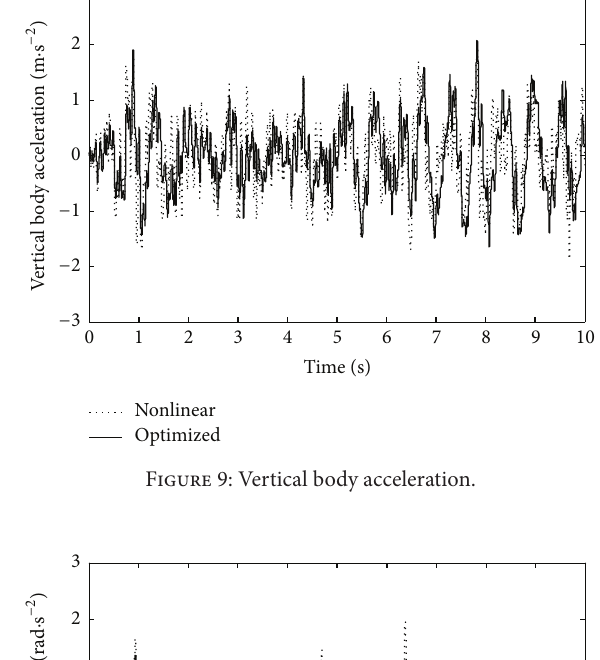
Table 2: Model parameters.